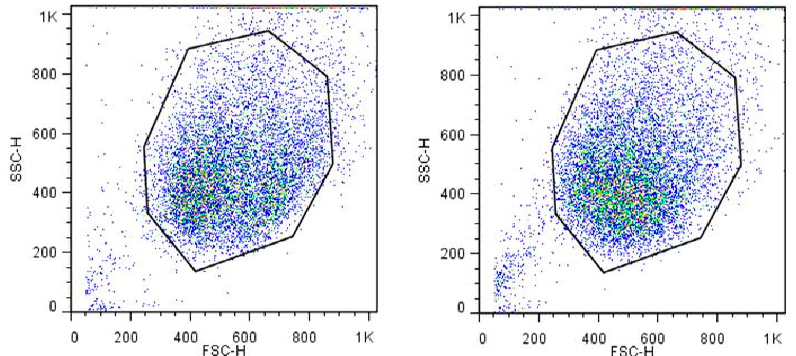
Figure 2. Flow cytometry determination of size and granularity of HaCaT cells after cultivation in DMEM (left) or PAM60 (right) for 3 h. No decisive differences can be seen between the dot plots of forward (FSC) and sideward scatter (SSC). Abbr.: DMEM: Dulbecco’s modified Eagle’s medium, PAM60: 60 s plasma-treated DMEM.